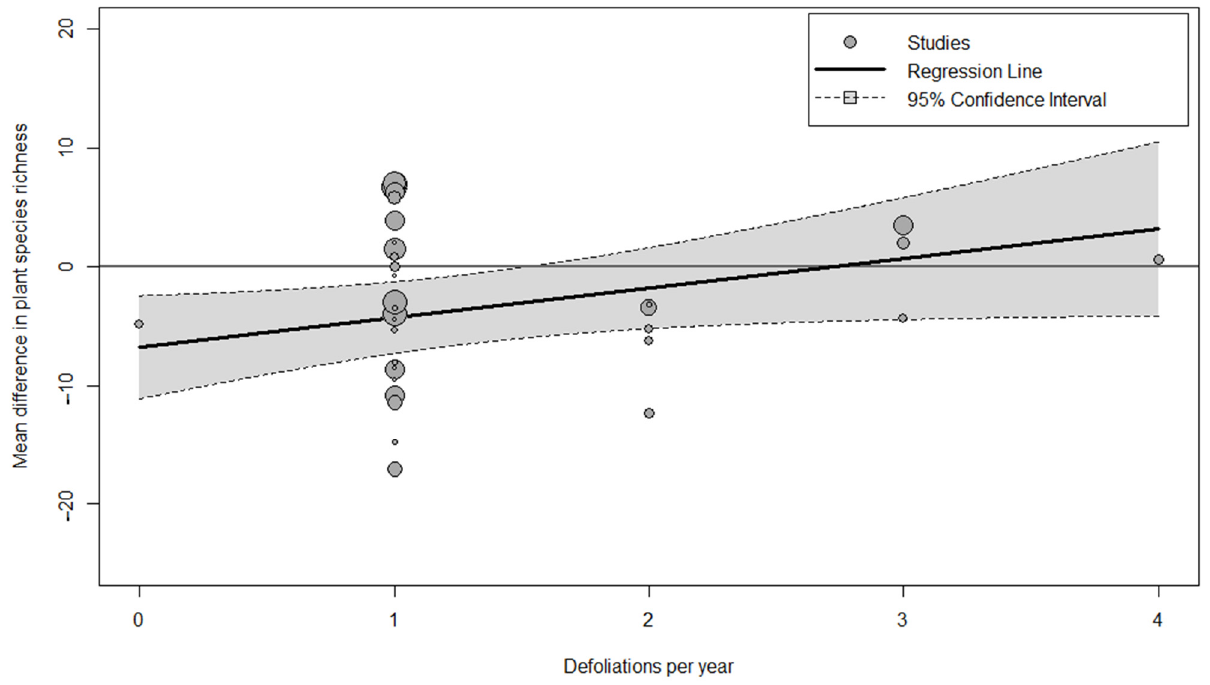
Figure 4. Mean difference in plant species richness with nitrogen addition in relation to the number of defoliation episodes per year from 14 studies included in the meta-analysis. Symbol size is a function of the weight in the model, with larger studies having a greater weight on model fit.